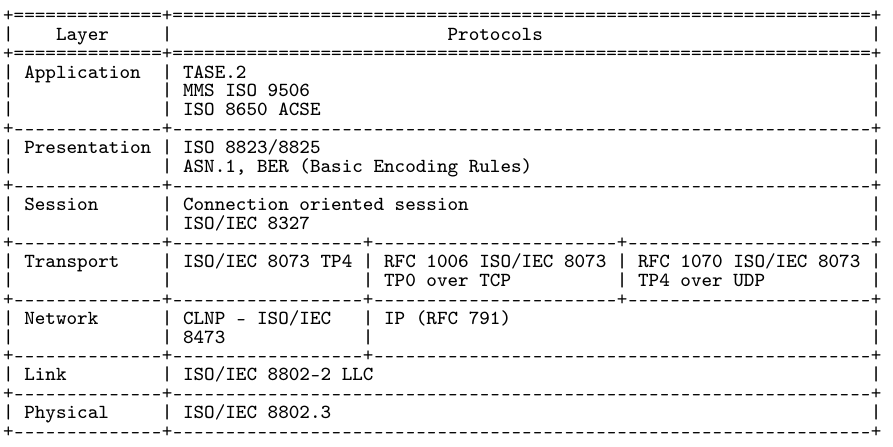
Figure 1. TASE.2 ISO/OSI communication